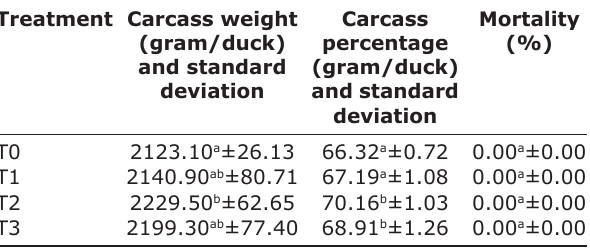
a,b Means in the same column, with different superscripts, represent significant differences between